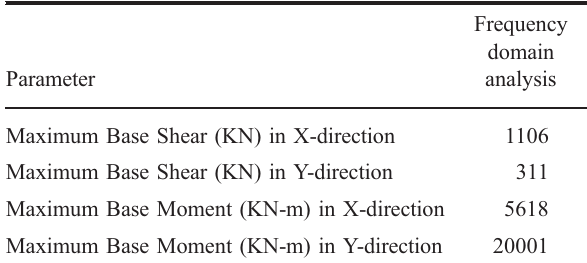
Table 7. Base shear and base moment in dynamic analysis (isolated building)